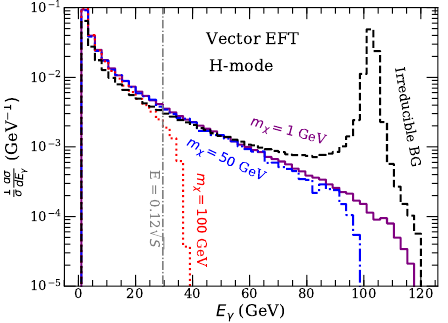
Figure 15 . Normalized E (cid:13) distribution in e + e (cid:0) ! (cid:31) (cid:22) (cid:31)(cid:13) for DM e(cid:11)ective operator (the vector case), along with the SM irreducible background, in the CEPC H -mode.